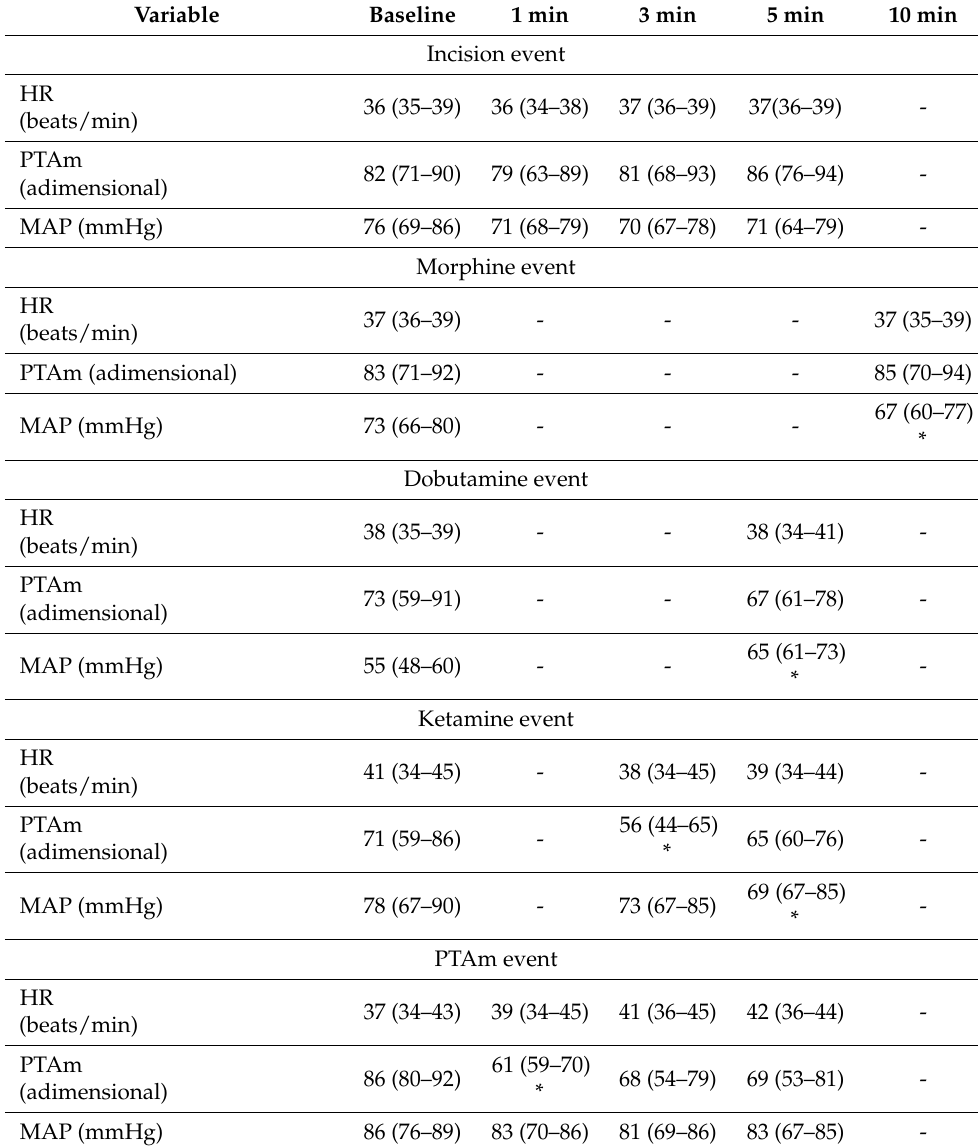
Table 1. Median (25th–75th percentile range) heart rate (HR), mean parasympathetic tone activity (PTAm), and mean arterial pressure